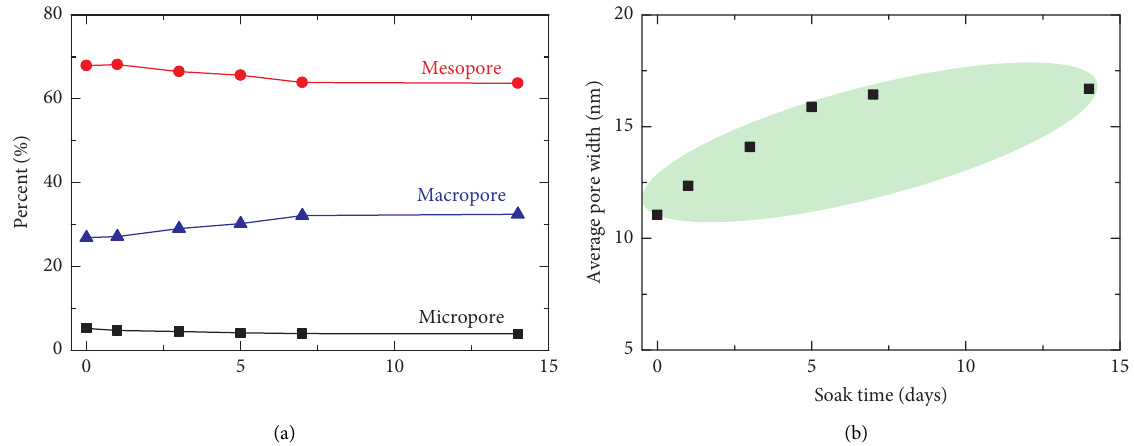
Figure 6: Pore volume and averaged pore volume alternation due to CO